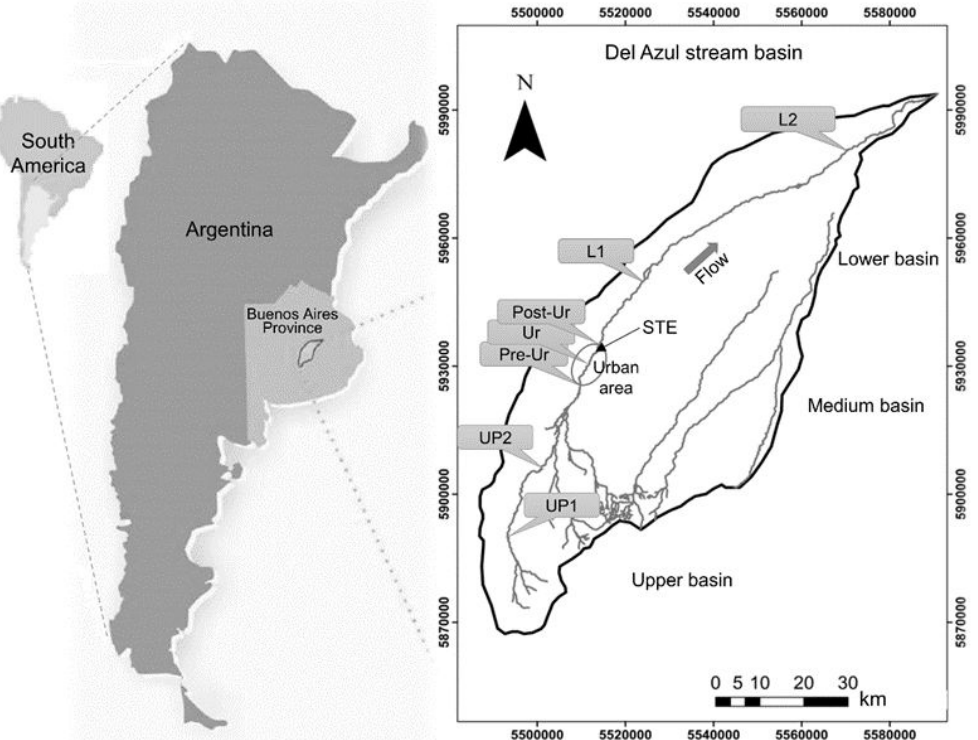
Figure 1. Location of the sampled reaches along the Del Azul stream. Please refer to the main text for reach acronyms meaning. STE: sewage treatment plant